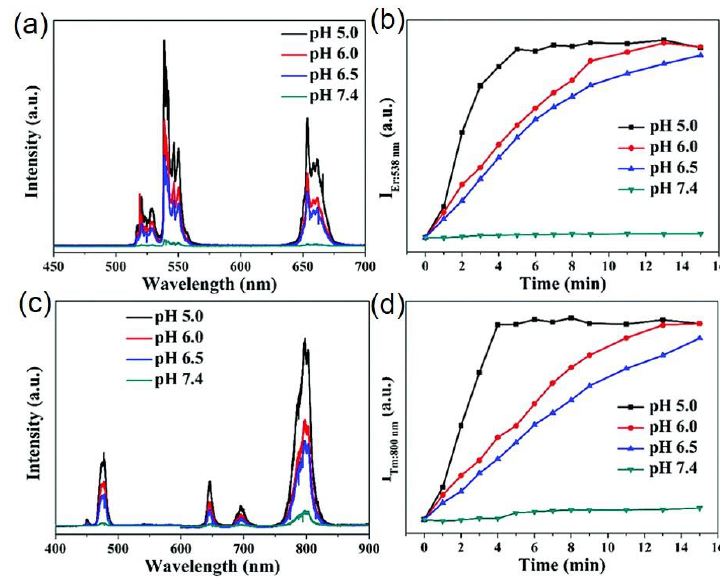
Figure 8. Upconversion response of: ( a ) NaYF 4 :Er 3+ /Yb 3+ @NaYF 4 @Ni; and ( c ) NaYF 4 :Tm 3+ /Yb 3+ @NaYF 4 @Ni nanoparticles in different pH solution. The plot of upconversion emission intensity a:t ( b ) 538 nm of Er 3+ ; and ( d ) 800 nm of Tm 3+ ions doped with Ni-modified UCNPs in different pH buffers versus of reaction time (Reproduced from Ref. [33] with permission from The Royal Society of Chemistry).